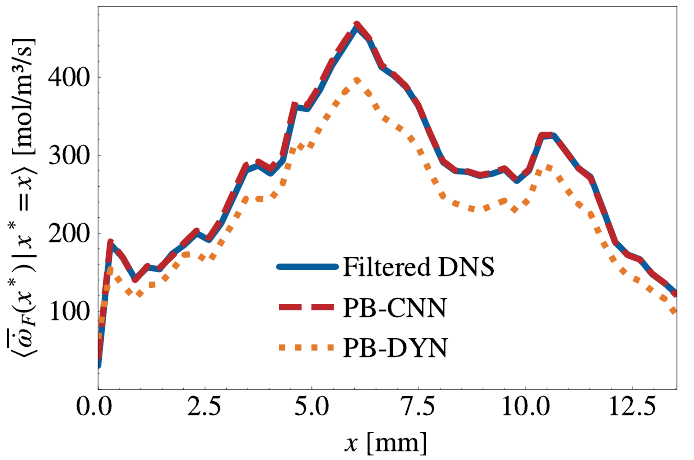
Figure 16. Evolution in the streamwise x direction of the true and modeled reaction rates averaged on yz -planes, for a sample in the HIT test set. PB-DYN denotes the Pfitzner beta PDF closure with the DYN model for c (cid:48) 2